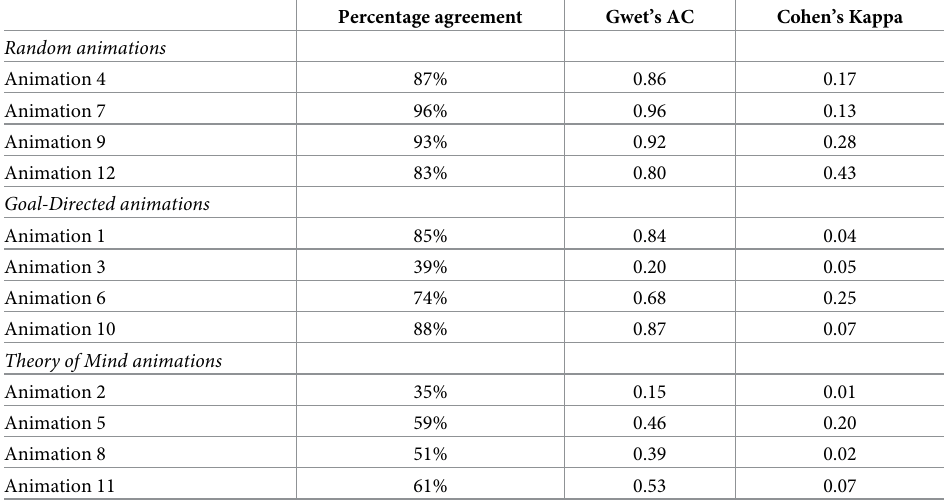
Table 3. Agreement between AT-MCQ categorizations and AT-verbal grouped intentionality scores.